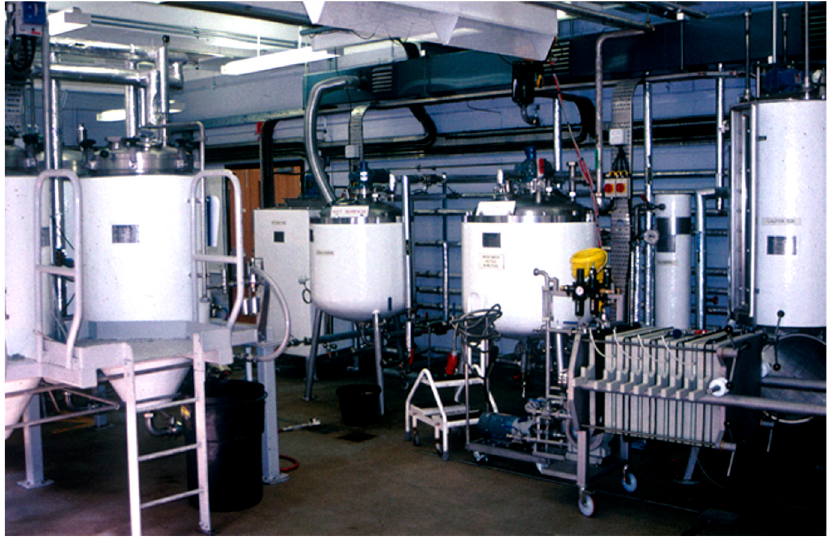
Figure 9. The 2hL brewing pilot plant at Heriot Watt University, Edinburgh.